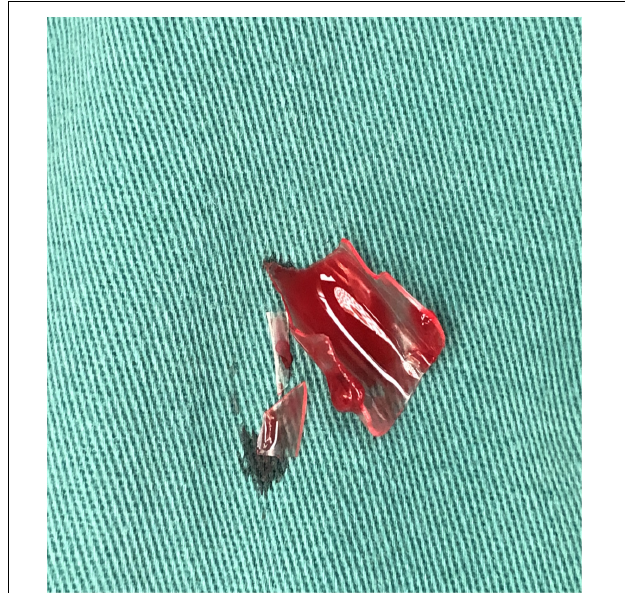
FIGURE 4 | Surgical specimen. A ring-shaped glass bottle with a length of about 1.2 cm and a diameter of 0.5 cm and three pieces of rice-sized glass slag were removed during the operation.